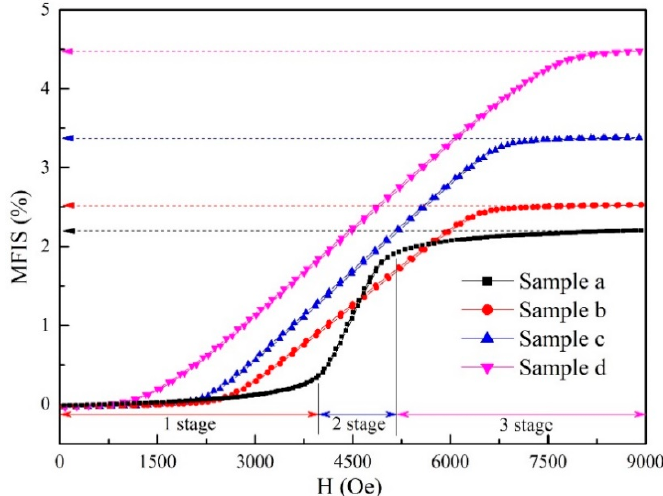
Figure 7. The MFIS curves of samples with different applied magnetic